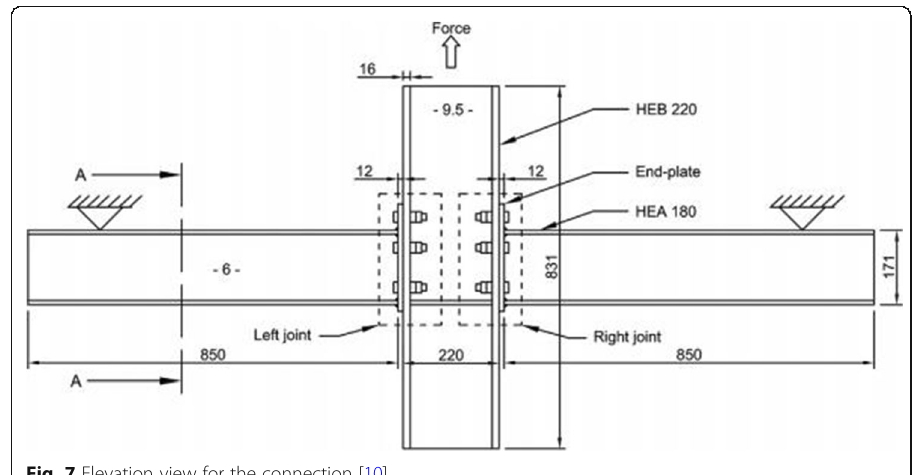
Fig. 7 Elevation view for the connection